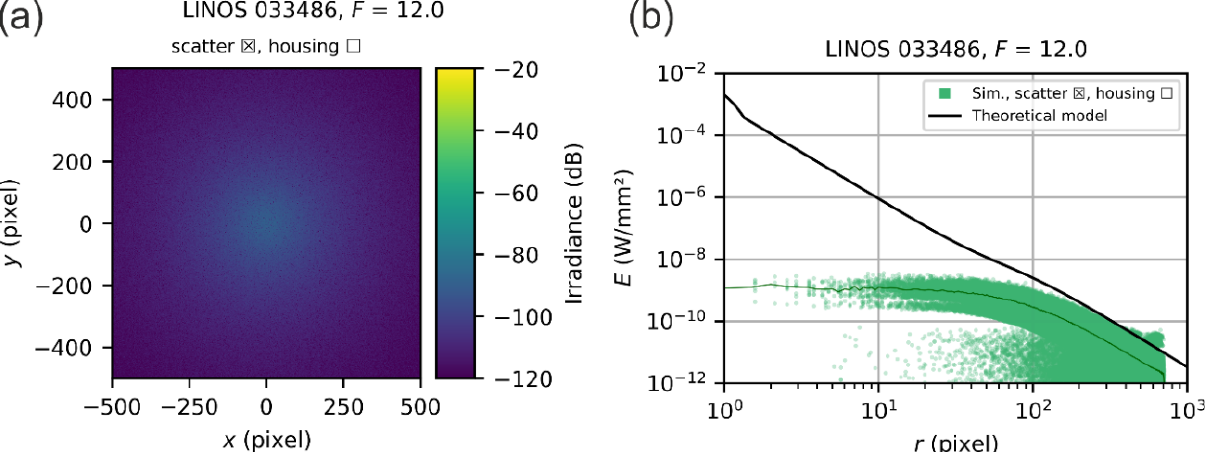
Figure 11. Simulation results for the LINOS 033486 lens and an f-number 𝐹 = 12 using the scatter-focused parameter set 2 with a low number of source rays but a high number of scattered rays. Only the scatter rays were analyzed. ( a ) Results represented as an image. ( b ) Results shown as a scatter plot. Please note: The curve of the theoretical model estimates the signal of both the diffractive component (regular rays) and the scatter component.